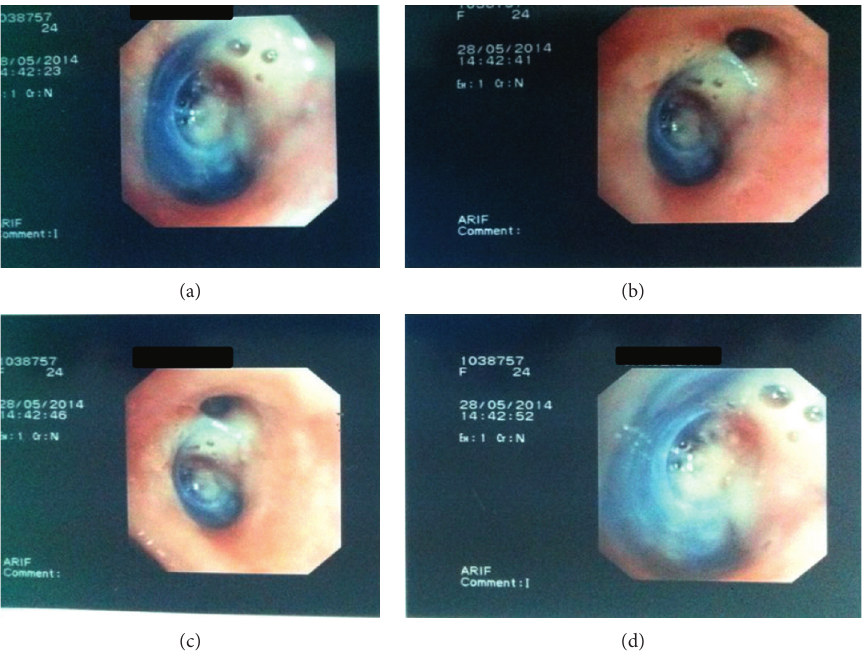
Figure 3: Bronchoscopy revealed a foreign body, which is blue in color at the entrance of the right lower lobe.